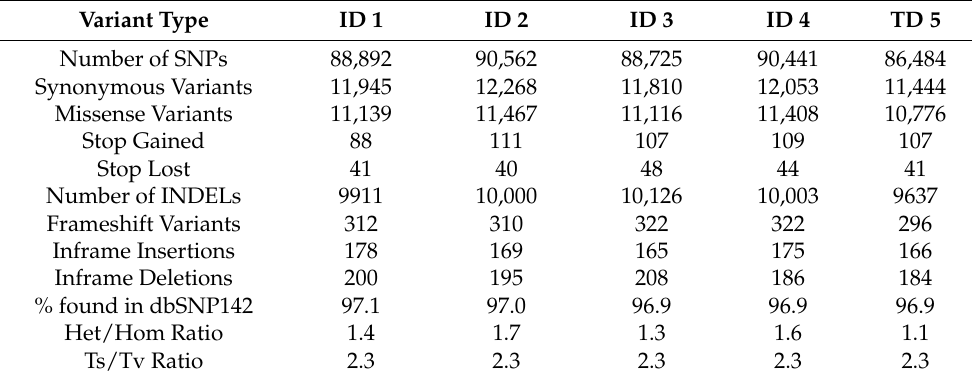
Table legend : WES: whole-exome sequencing; WBC: white blood cell; CP: chronic phase; AP: accelerated phase; BC: blast phase; CP-CML: chronic-phase chronic myeloid leukemia; AP-CML: accelerated-phase chronic myeloid leukemia; BC-CML: blast-phase chronic myeloid leukemia. Table 5. Different types of variants identified in each exome sequenced